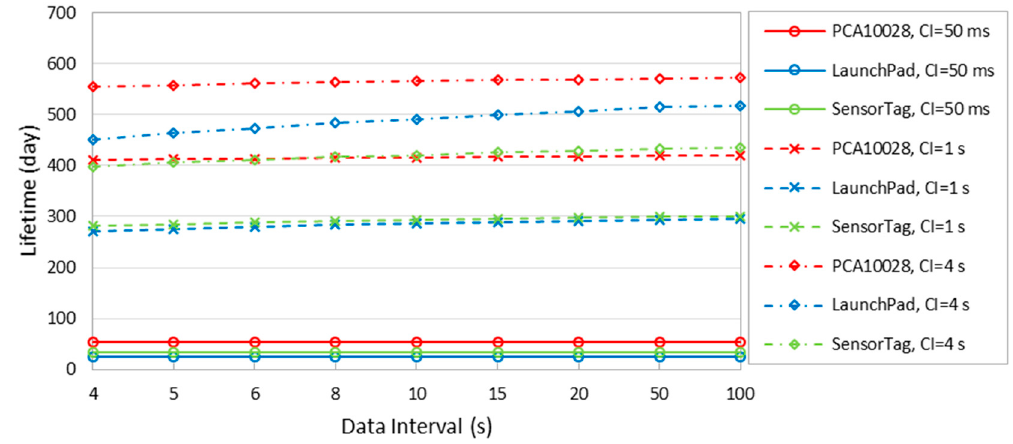
Figure 17. Device lifetime in terms of different connInterval and data intervals.